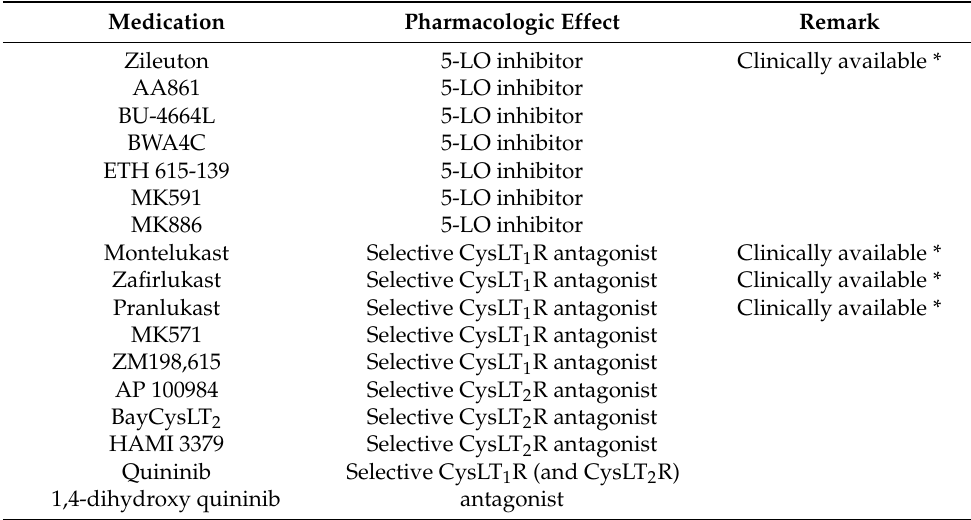
Table 1. Cysteinyl leukotriene pathway